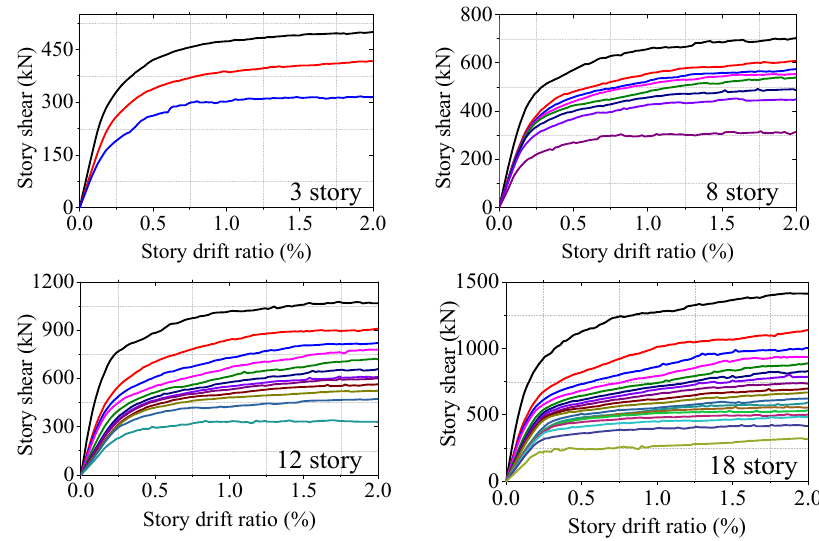
Figure 6. Actual story capacity curves by using IDA method.